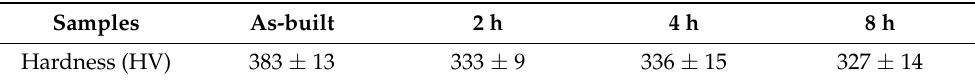
Table 3. Average hardness of the as-built and heat-treated samples after heat treatment at various times.